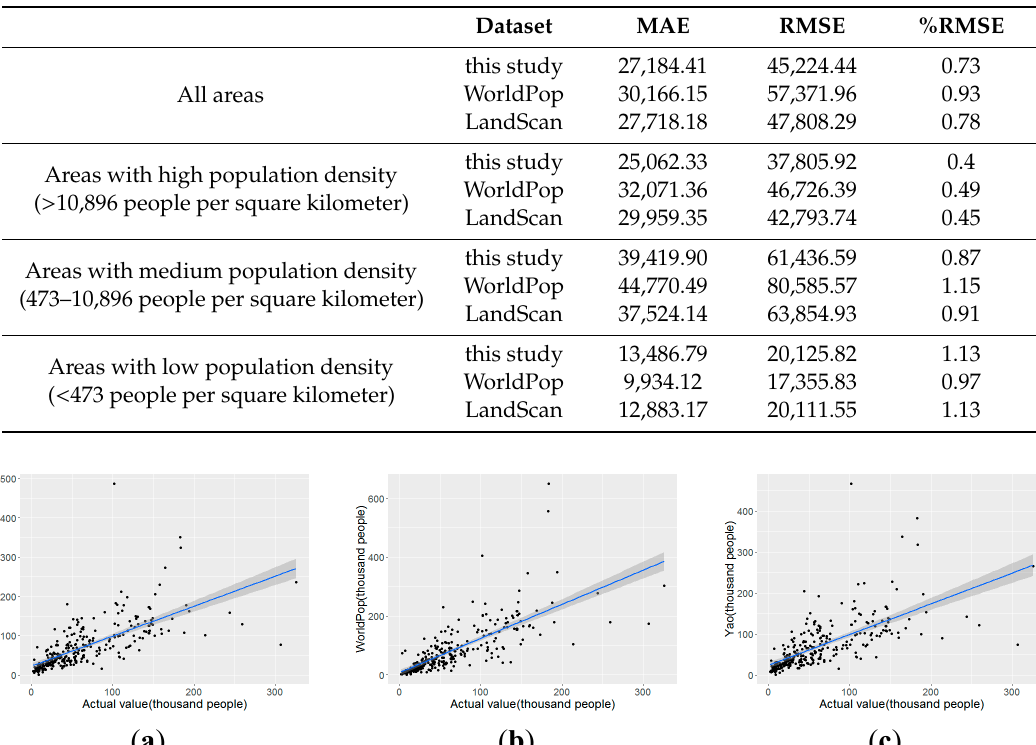
Table6. AccuracyassessmentofPSP-drivendasymetricmodelresultsinvariousregionsandcomparison with the two reference datasets.